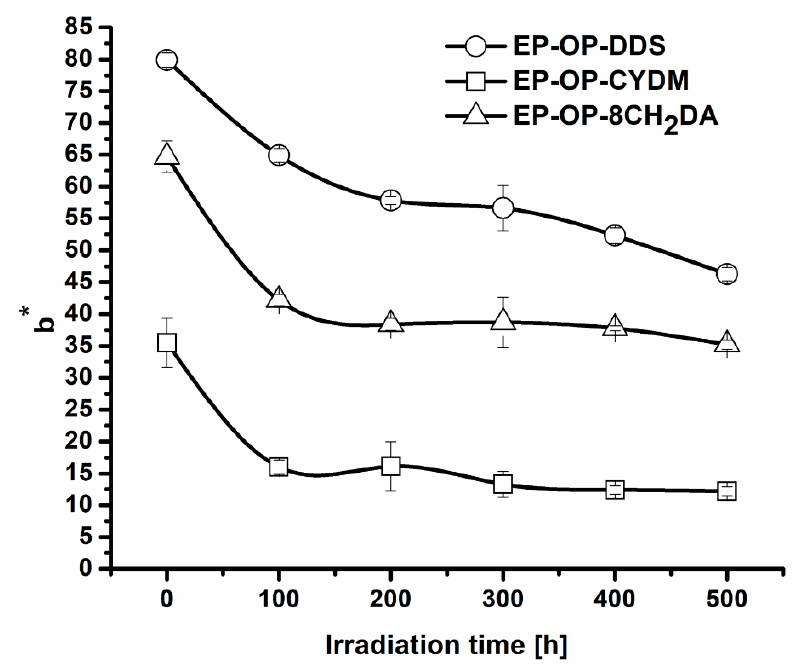
Figure 3. Variation of the b * parameter with irradiation time.